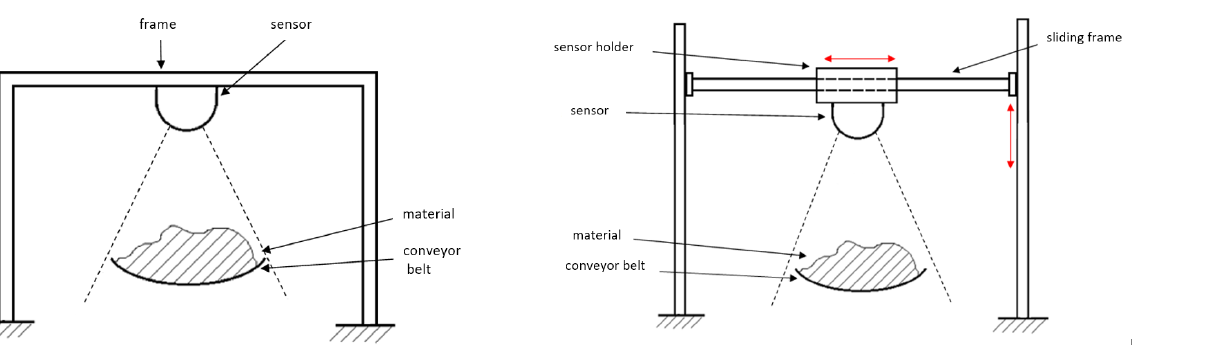
Figure 6: Rigid frame